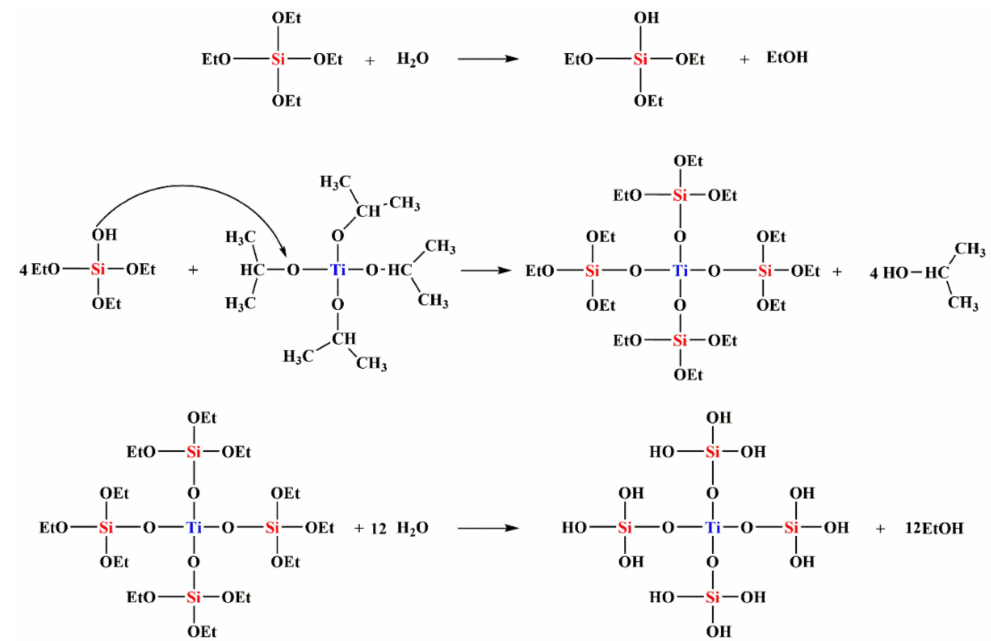
Figure 7. Proposed probable mechanism for synthesized Ti x Si y